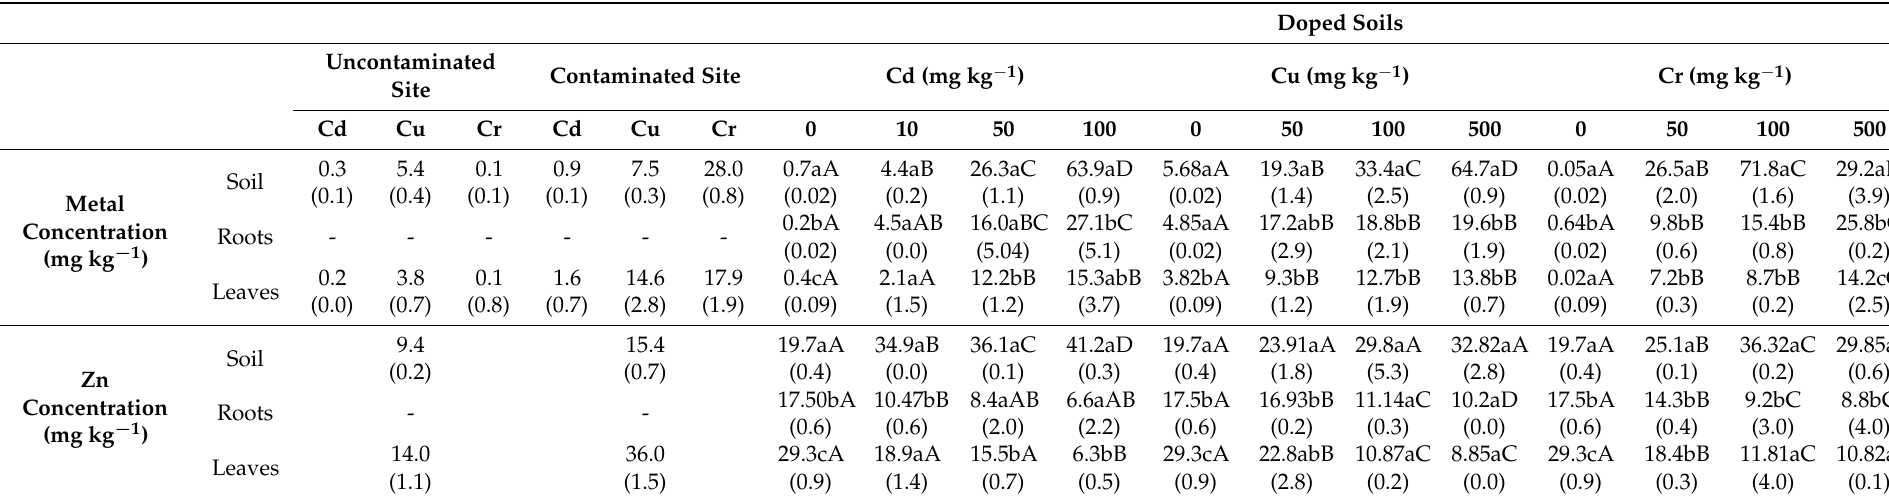
Table 1. Mean metals content in different compartments of site collected samples and ex-situ experiments.